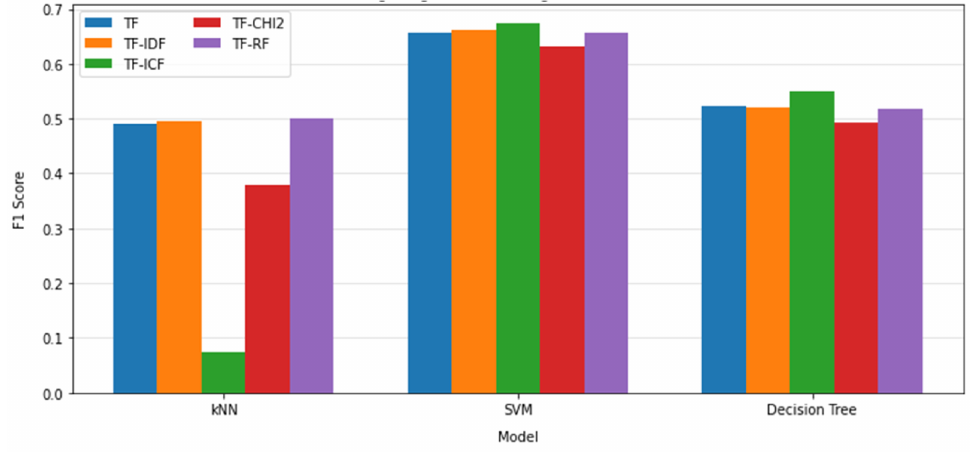
Fig. 5 The result of the F1 score for each term-weighting scheme using a combination of uni-gram and bi-gram The last test results on the combinations of uni-gram, bi-gram, and tri-gram are shown in Table 3. Unlike the previous two tests, k-NN showed the best performance when using TF-IDF, with an accuracy of 0.5091 and an F1 score of 0.4984. In comparison, the decision tree’s accuracy was 0.5564, and F1 score was 0.5582 in the TF-ICF scheme. SVM using TF-IDF showed the best performance, with an accuracy of 0.6673 and an F1 score of 0.6635. Fig. 6 shows the F1 test results of the term-weighting schemes with the three classification algorithms. The term- weighting scheme with the unsupervised approach shows a better average F1 score for each classifier model. Based on the results of the three tests, the overall performance of the term-weighting scheme and the classifier model increases when using a uni-gram combination. The performance trend declines when using a triadic combination of uni-gram, bi-gram, and tri-gram. Meanwhile, SVM seems the most stable classifier model because it shows the best performance in the three tests. TF-ICF and TF-RF are term-weighting schemes that show the best performance among other schemes. The term-weighting scheme with the supervised method shows consistent results with different classifiers in various